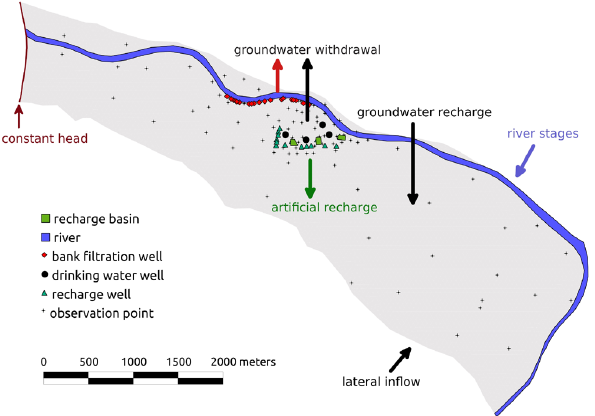
Fig. 1. Schematic representation of model domain and boundary conditions.